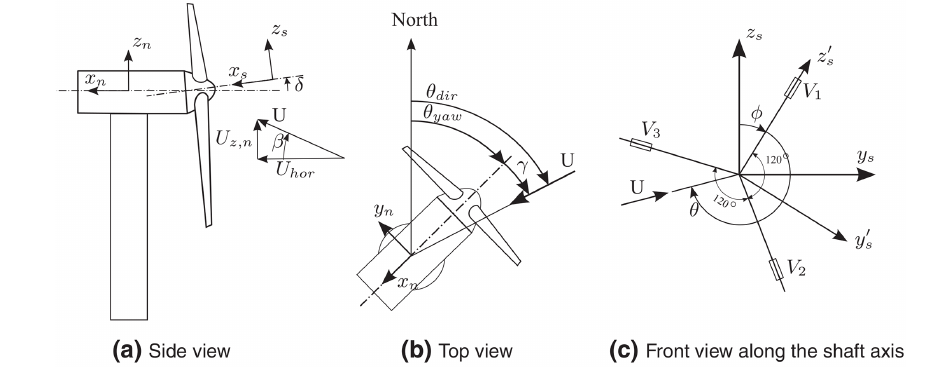
Figure 1. Coordinate systems and definition of angles: rotating spinner coordinate system x (cid:48) s , y (cid:48) s and z (cid:48) s ; non-rotating shaft coordinate system x s , y s and z s ; fixed nacelle coordinate system x n , y n and z n ; yaw direction θ yaw ; yaw misalignment γ ; flow inclination angle β ; tilt angle δ ; azimuth position of flow stagnation point on spinner θ (relative to sonic sensor 1) and rotor azimuth position φ (position of sonic sensor 1 relative to vertical). From Demurtas et al.